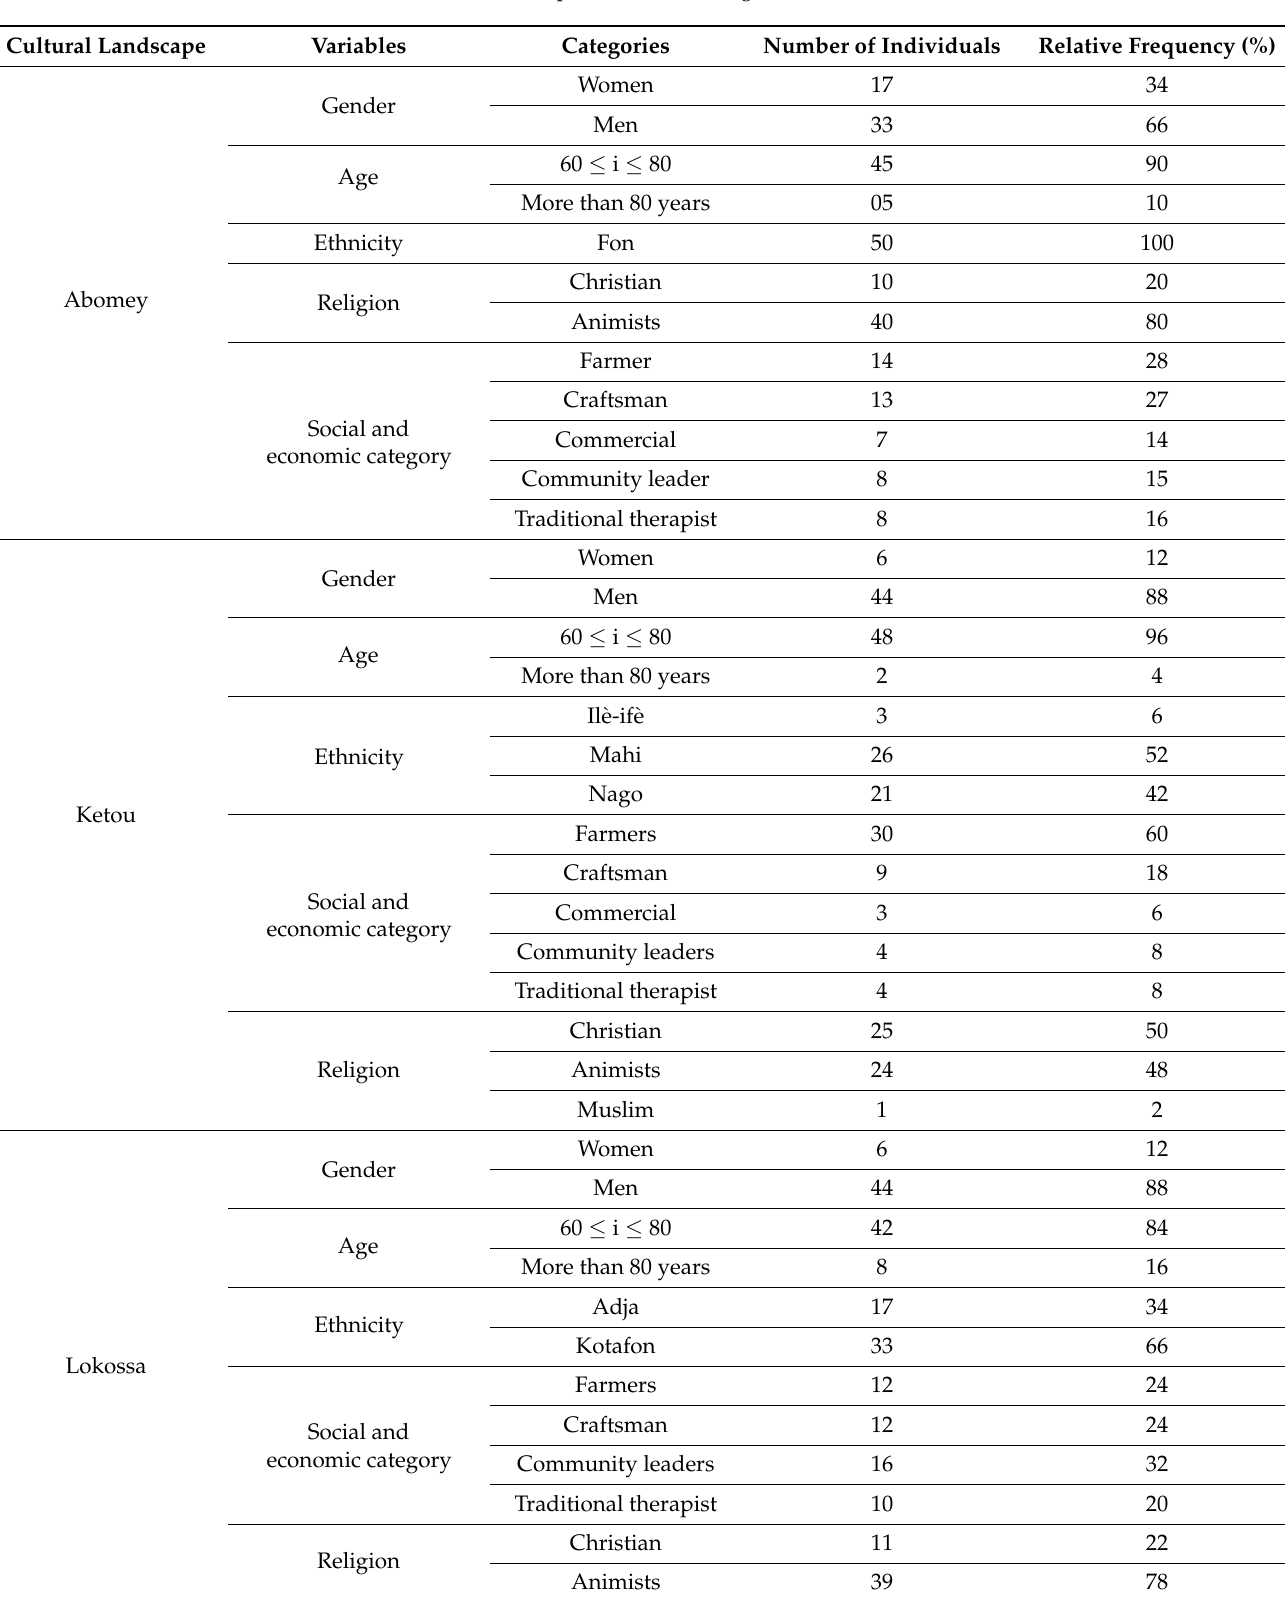
Table 1. Profile of the respondents according to